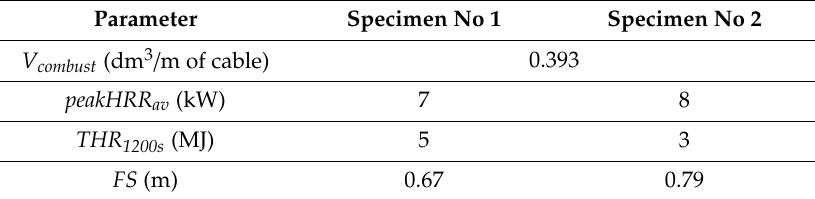
Table 2. Comparison of EN 50399 test results obtained for two specimens of 19-core cable.